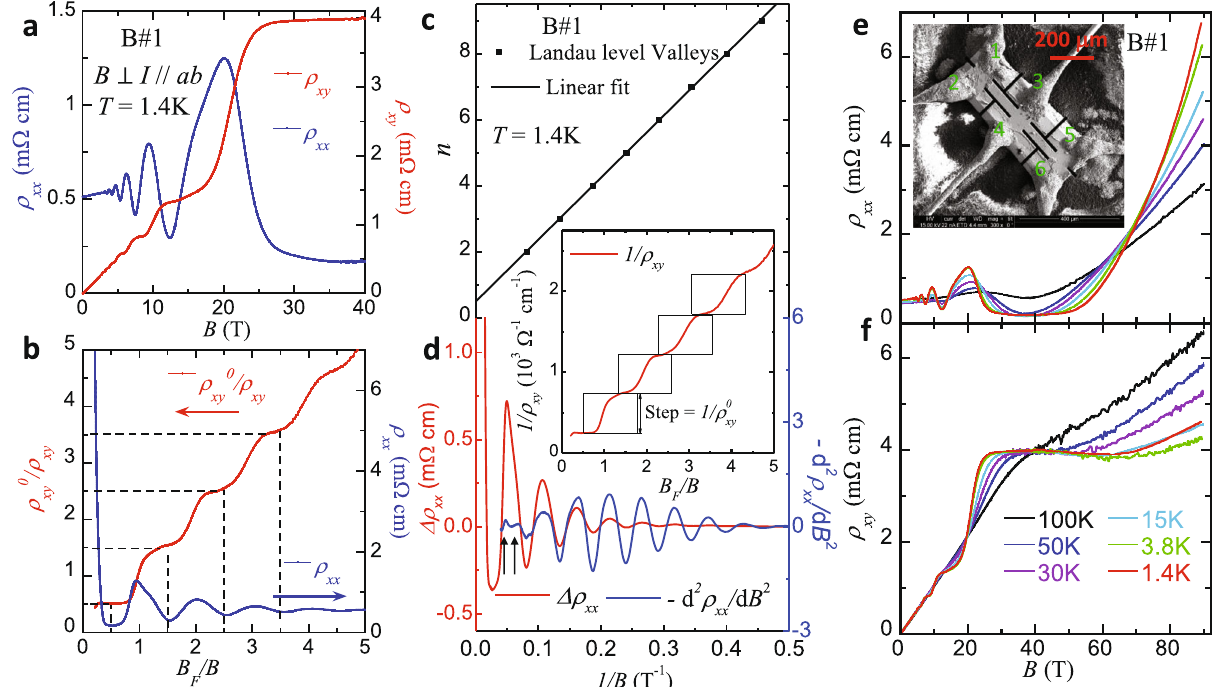
Fig. 3 Bulk quantum Hall effect in BaMnSb 2 . a Magnetic fi eld dependences of in-plane resistivity ( ρ xx , blue) and Hall resistivity ( ρ xy , red) at T = 1.4 K for the Hall bar sample B#1, measured with fi eld perpendicular to the Sb-plane up to 40 T. Hall plateaus in ρ xy are clearly observed. b Normalized inverse Hall resistivity ( ρ 0 xy = ρ xy ) and in-plane resistivity ( ρ xx ) versus B F = B . 1 = ρ 0 xy is de fi ned as the step size between the fi rst and the second plateaus of 1 = ρ xy (see the inset to panel d ). B F is the frequency of the SdH oscillations in ρ xx . c Landau level fan diagram built from the SdH oscillations of ρ xx at 1.4 K. d The second derivative, (cid:1) d 2 ρ xx = dB 2 , which is in phase with ρ xx , clearly reveals the oscillation peak splitting near B = 17 T. The inset shows the inverse of ρ xy in panel a as a function of B F / B . 1/ ρ 0 xy is determined by the vertical interval between steps. e , f Field dependences of ρ xx and ρ xy at various temperatures ( T = 1.4, 3.8, 15, 30, 50, and 100 K), up to 90 T. The inset in ( e ) shows the SEM image of sample B#1 with Hall bar geometry fabricated by